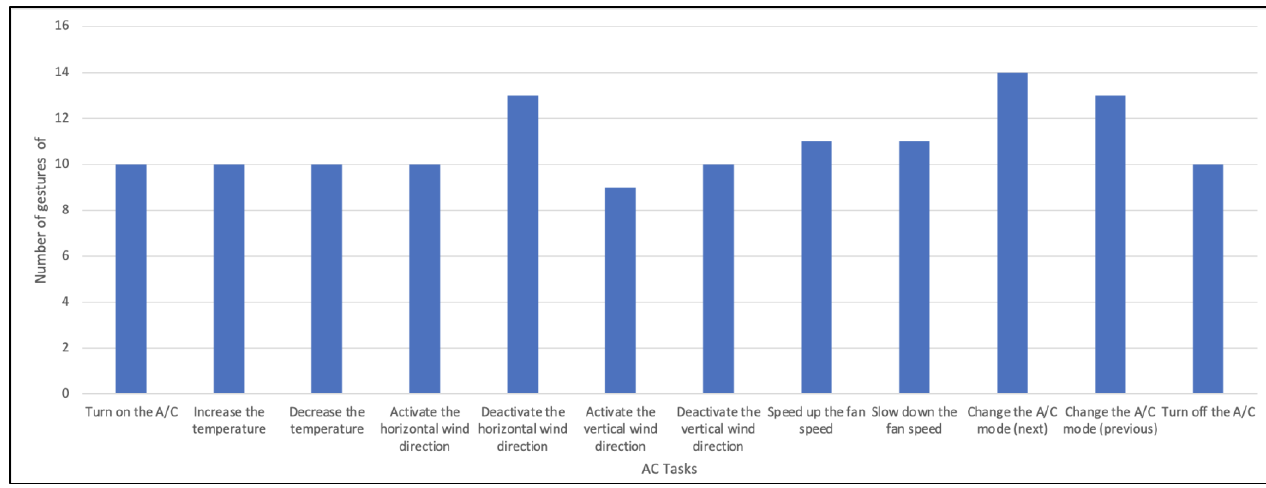
Figure 6. Number of gesture criteria for each task.